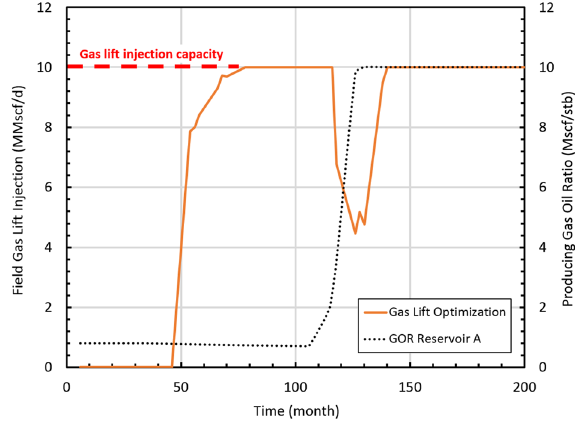
Fig. 11 Optimal field gas lift rate as a function of